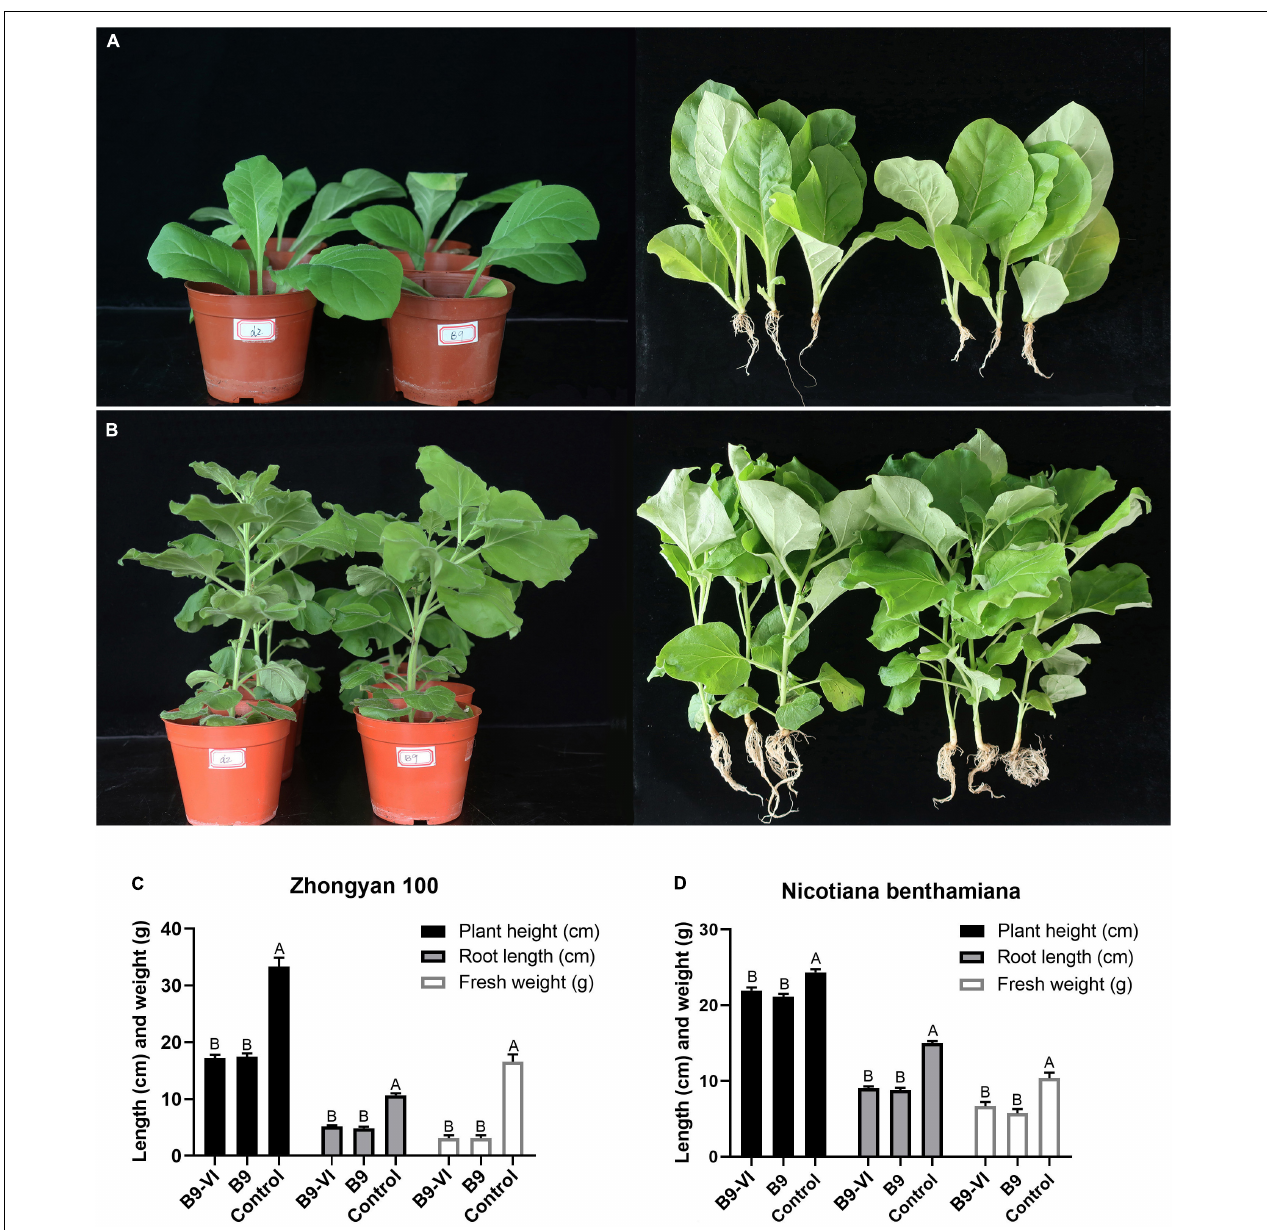
FIGURE 5 | Comparison of pathogenicity between F. oxysporum strain B9-VI (virus infect) and B9 (virus-free) on the tobacco cultivar ‘Zhongyan 100’ and N. benthamiana . (A) Strain B9-VI and B9 inoculated tobacco cultivar ‘Zhongyan 100’ were grown in pots for 31 days (left), and comparison of growth status of plants inoculated with strain B9-VI and B9 (right). (B) Strain B9-VI and B9 inoculated tobacco cultivar N. benthamiana were grown in pots for 31 days (left), and comparison of growth status of plants inoculated with strain B9-VI and B9 (right). (C,D) Average plant height, root length, and fresh weight of two tobacco cultivars inoculated with strain B9-VI and B9. Strain B9-VI infects by FoMyV1, strain B9 is the mycovirus-free. The “control” in panels (C,D) represents plants that have not been inoculated with any